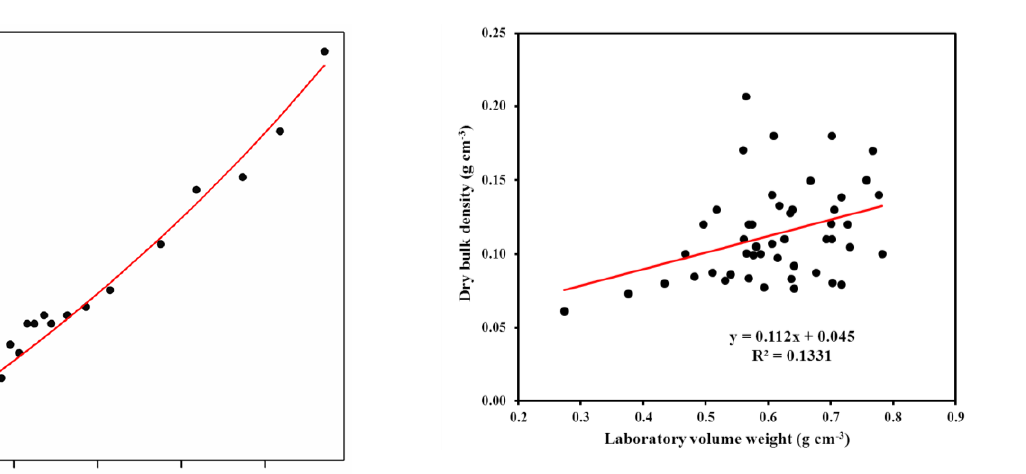
Figure 3. Regression of dry bulk density on laboratory volume weight for a set of Scottish peat samples (Middlemuir, Red Moss and NSIS).